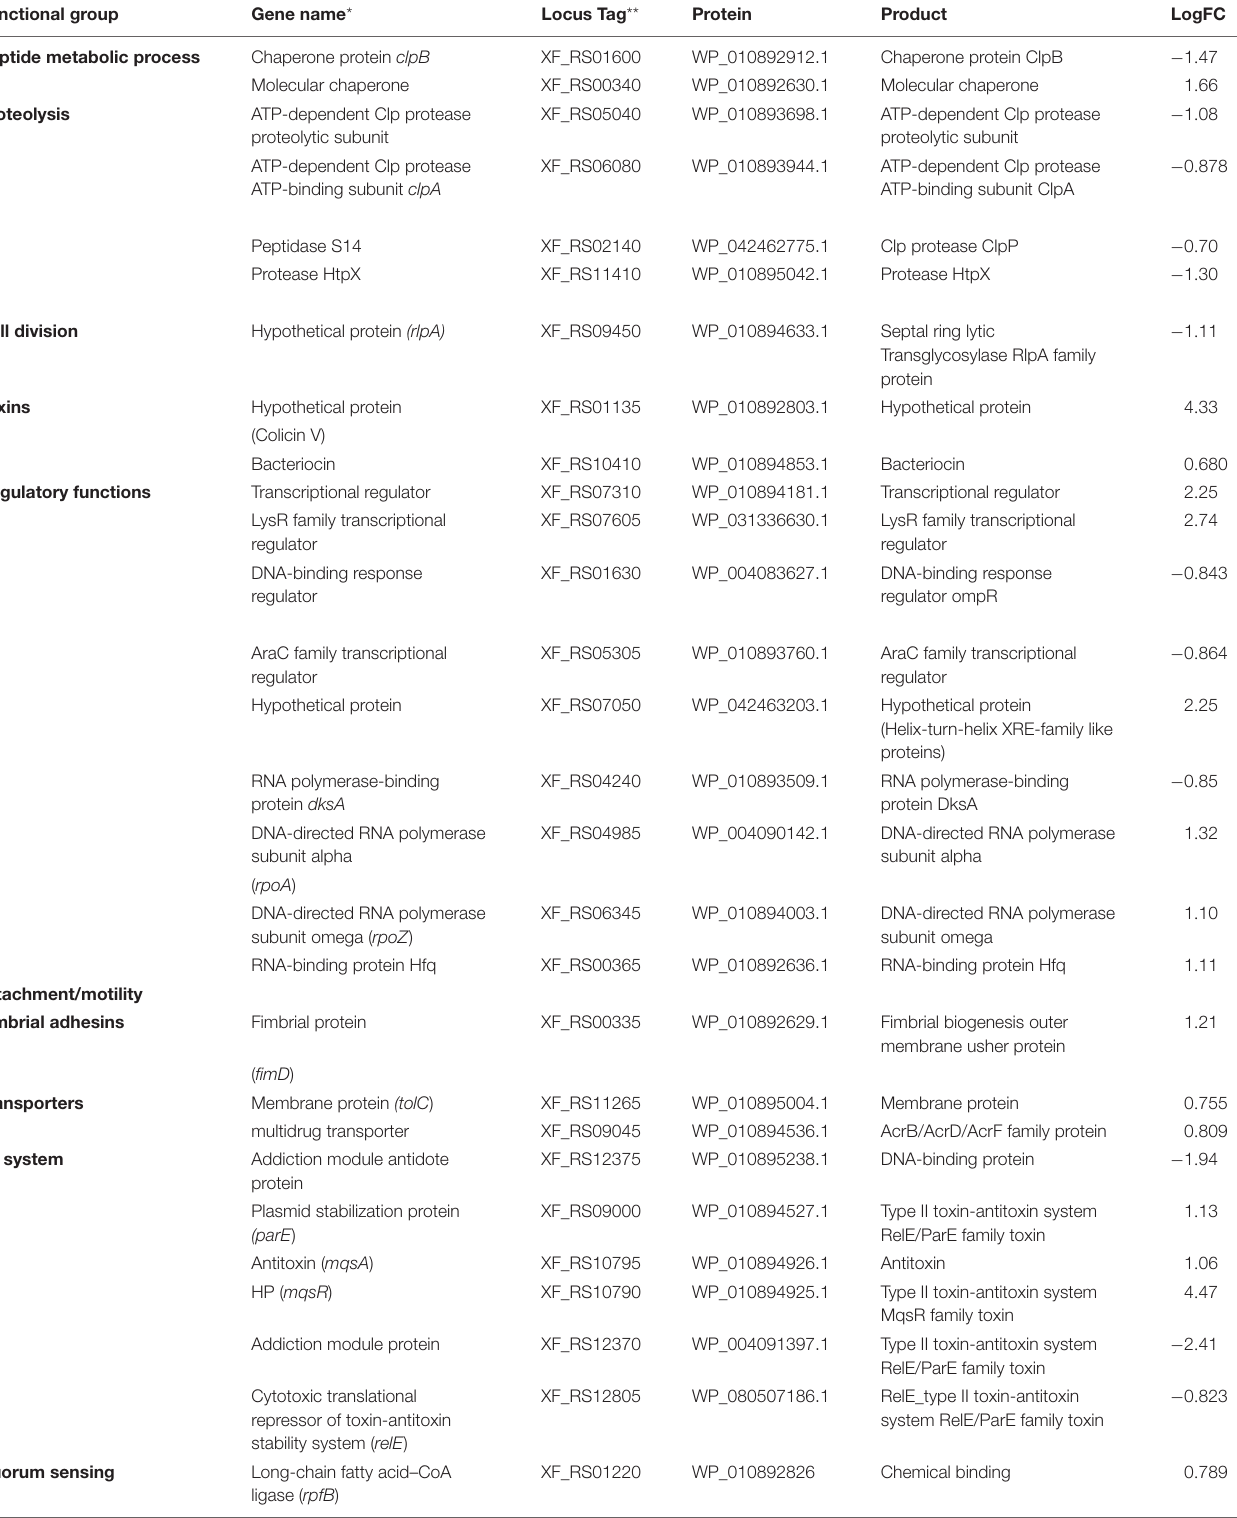
TABLE 1 | Genes modulated by MqsR in X.